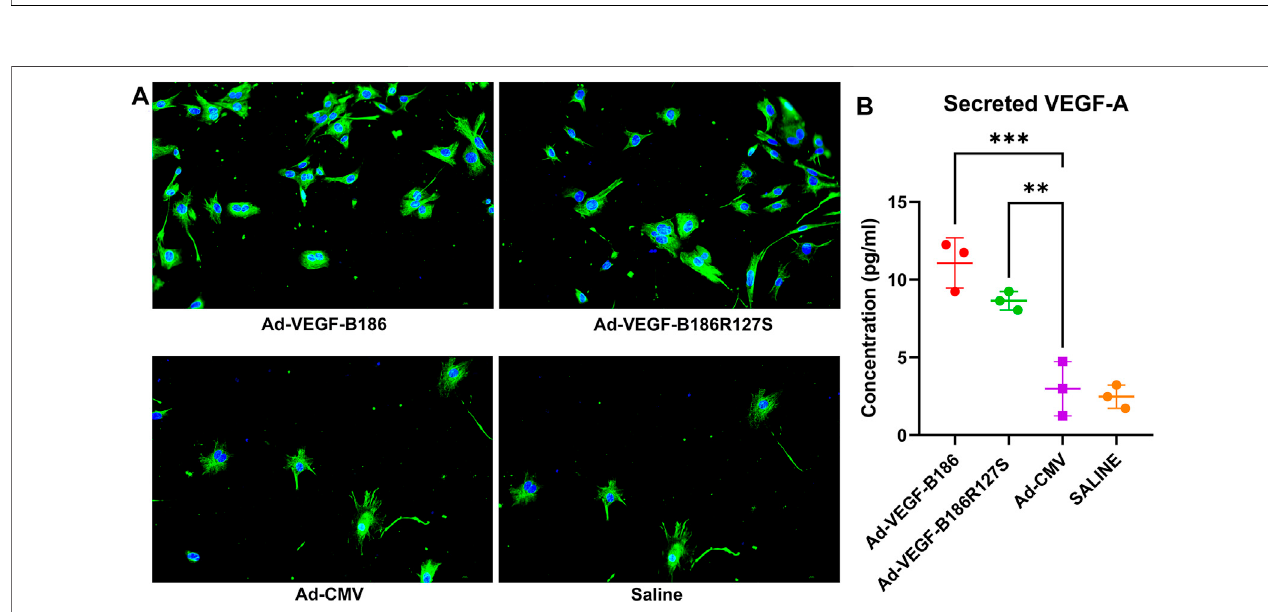
FIGURE8| EndothelialprogenitorcellssecreteVEGF-A. (A) RepresentativeimagesofVEGF-A(green)stainedendothelialprogenitorcellsoncultureday15;Scale bars, 10 μ m. (B) Quanti fi cation of VEGF-A concentrations from cultured EPC supernatants. Each dot indicates cultured EPC from one mouse; n = 3 in Ad-VEGF-B186, n = 3 in Ad-VEGF-B186R127S, n = 3 in Ad-CMV, and n = 3 in saline groups. Horizontal bars indicate mean ± SD and p values vs. each group by one-way ANOVA, followed by Dunnett ’ s multiple comparison test.